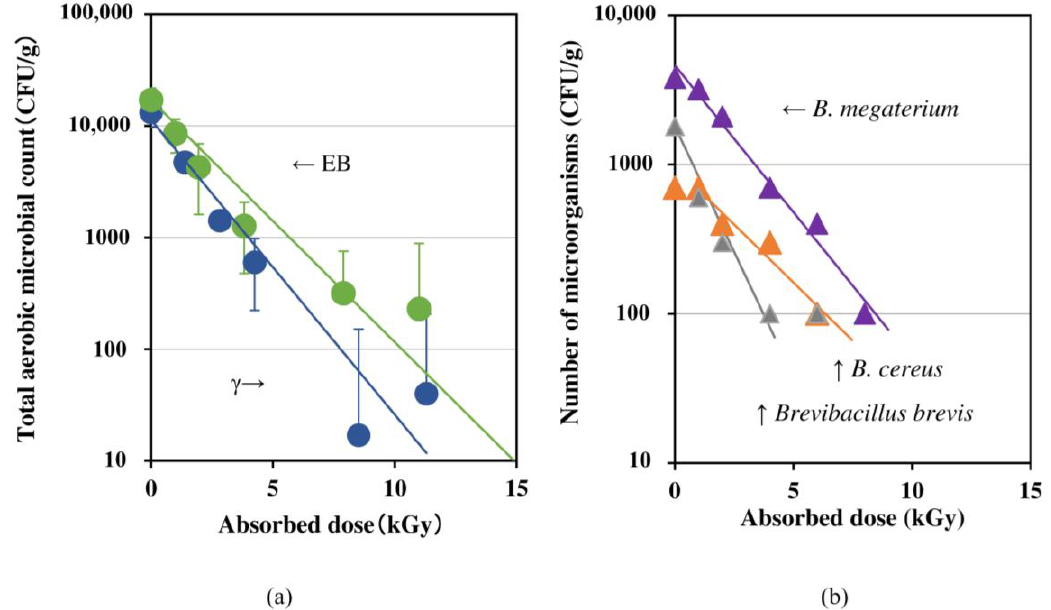
Figure 1. Survival curves of microbes in the sample pills irradiated by ionized radiation. ( a ) Survival curves of the total aerobic microbial count (TAMC) related with irradiations. Gamma rays are represented by blue circles with a line of y = 1.3 × 10 4 e − 0.63x . The electron beam is represented by green circles with a line of y = 1.7 × 10 4 e −0.50x . ( b ) Survival curves of the genus of spore species by γ -irradiation. Bacillus megaterium is represented by purple triangles with a line of y = 5.3 × 10 3 e − 0.48x . Bacillus cereus is represented by orange triangles with a line of y = 9.7 × 10 2 e −0.36x . Brevibacillus brevis is represented by gray triangles with a line of y = 1.8 × 10 3 e −0.77x .